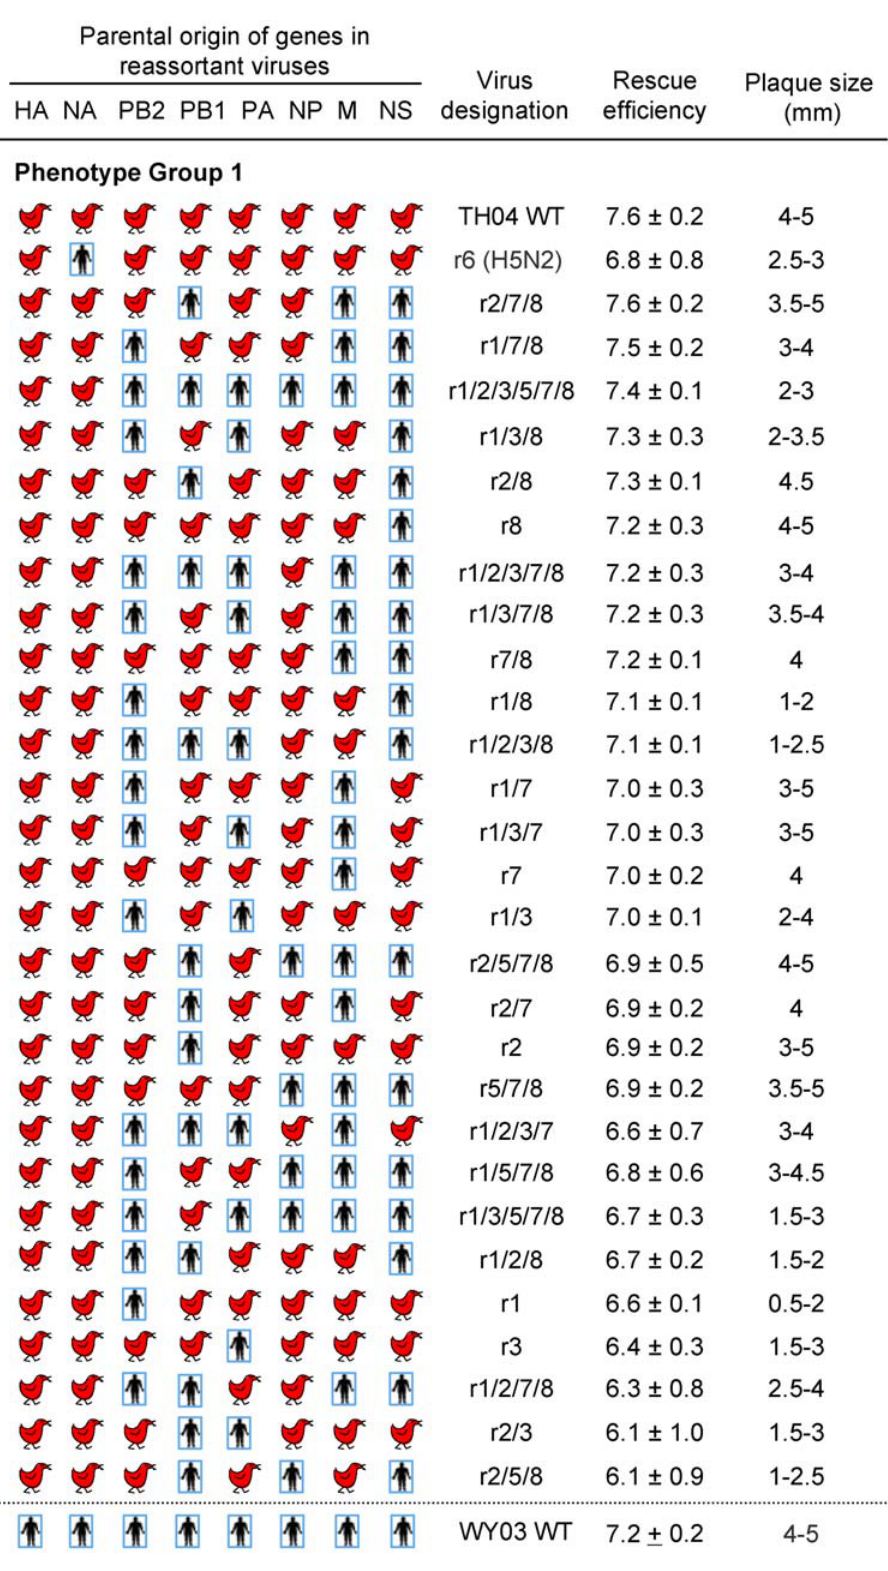
Figure 1. Characteristics of high yield avian-human reassortant viruses in cell culture. Human and chicken symbols denote the parental WY03 or TH04 source of each gene segment. The genotype of reassortants (r) is denoted by the genes derived from WY03 virus, designated by their segment number; 1:PB2. 2:PB1. 3:PA. 4:HA. 5:NP. 6:NA. 7:M. 8:NS. All others genes derived from TH04 do not bear a number. For example, r3/8 indicates the reassortant virus carries PA and NS genes from WY03 virus, and the remaining segments from TH04 virus. Rescue efficiency represents the virus titer (log 10 pfu/ml) from cell cultures at 72 hours after transfection; geometric mean from 3 independent experiments. doi:10.1371/journal.ppat.1000072.g001 PLoS Pathogens |